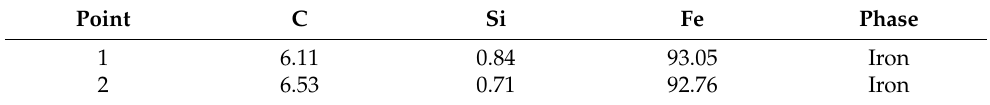
Table 8. Chemical composition of points indicated in Figure 13